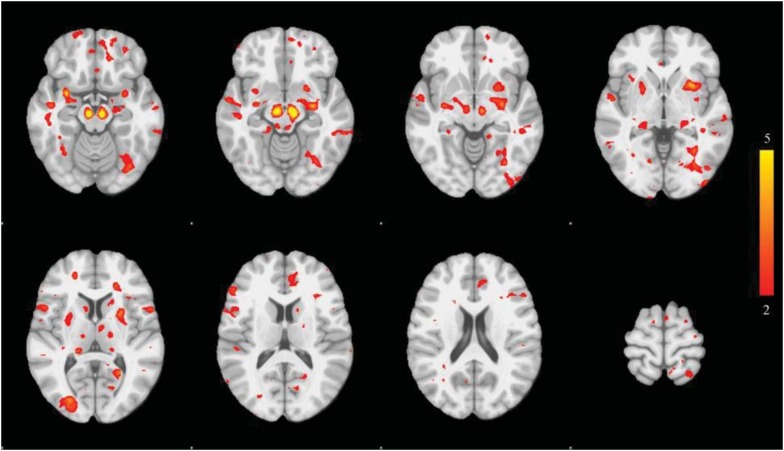
DOI:
http://dx.doi.org/10.7554/eLife.08440.025